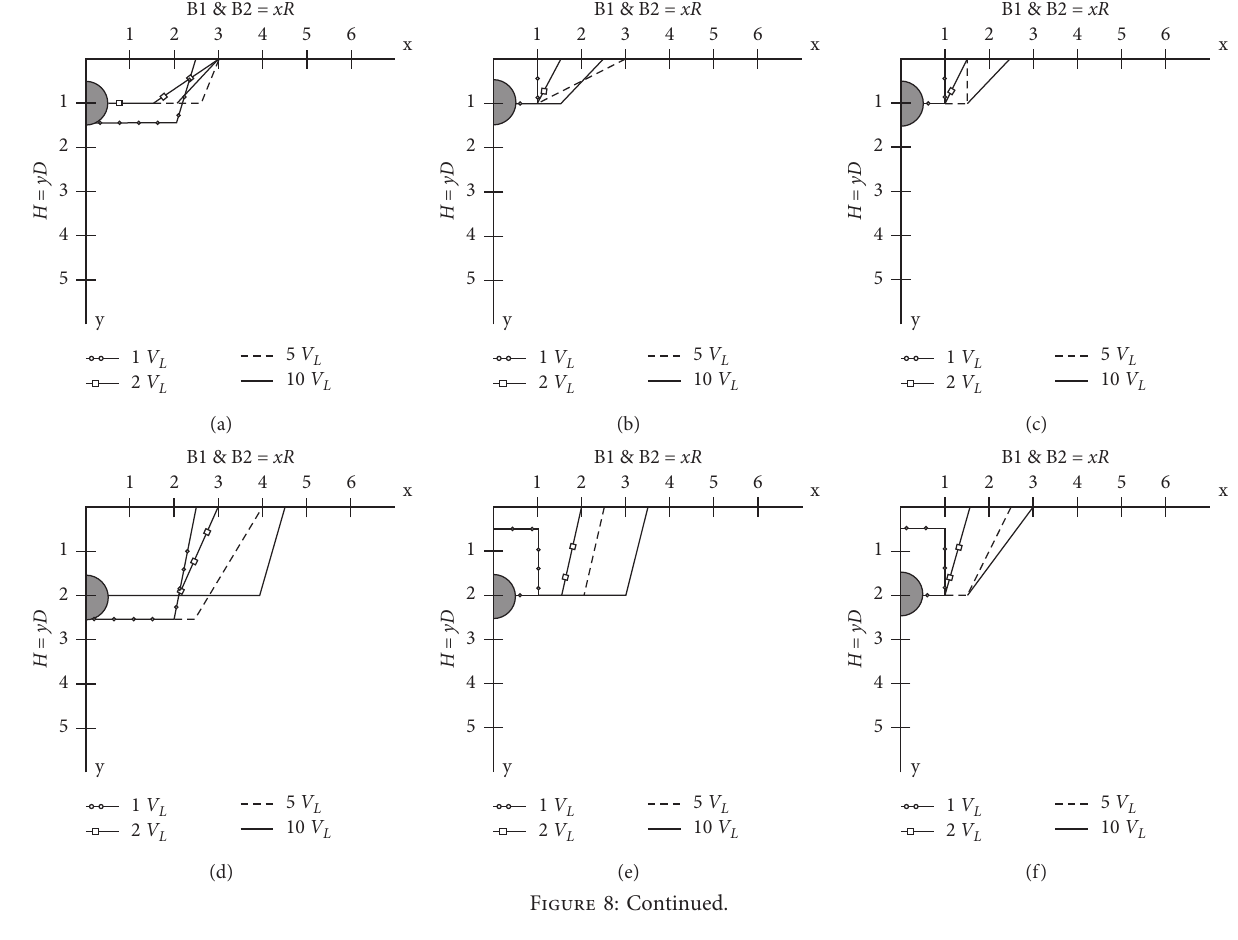
Figure 7: Influence zones for tunnel size, D � 3 m. (a)–(c) Tunnel placed at depth of tunnel size “ D ” for various volume loss percentage “ V (d)–(f) Tunnel placed at twice the depth of tunnel size “ D. ” (g)–(i) Tunnel placed at thrice the depth of tunnel size “ D .” (a) D � 3 m and z � 1 D in LS. (b) D � 3 m and z � 1 D in MDS. (c) D � 3m and z � 1 D in DS. (d) D � 3m and z � 2 D in LS .(e) D � 3m and z � 2 D in MDS .(f) D � 3m and z � 2 D in DS .(g) D � 3 m and z � 3 D in LS. (h) D � 3m and z � 3 D in MDS. (i) D � 3m and z � 3 D in